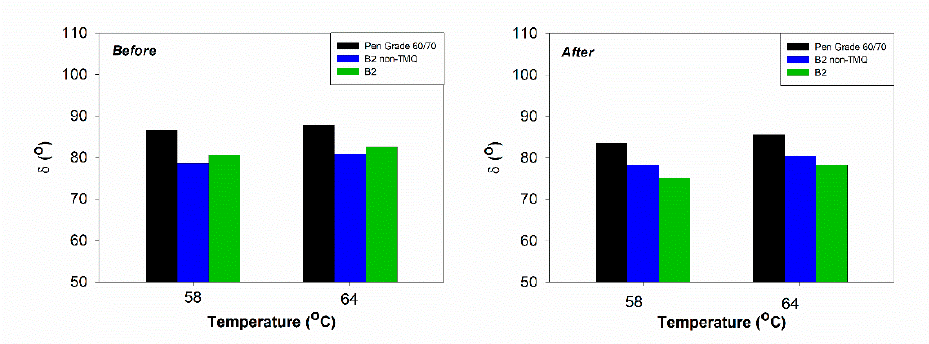
Figure 10. Phase angle before and after RTFOT.